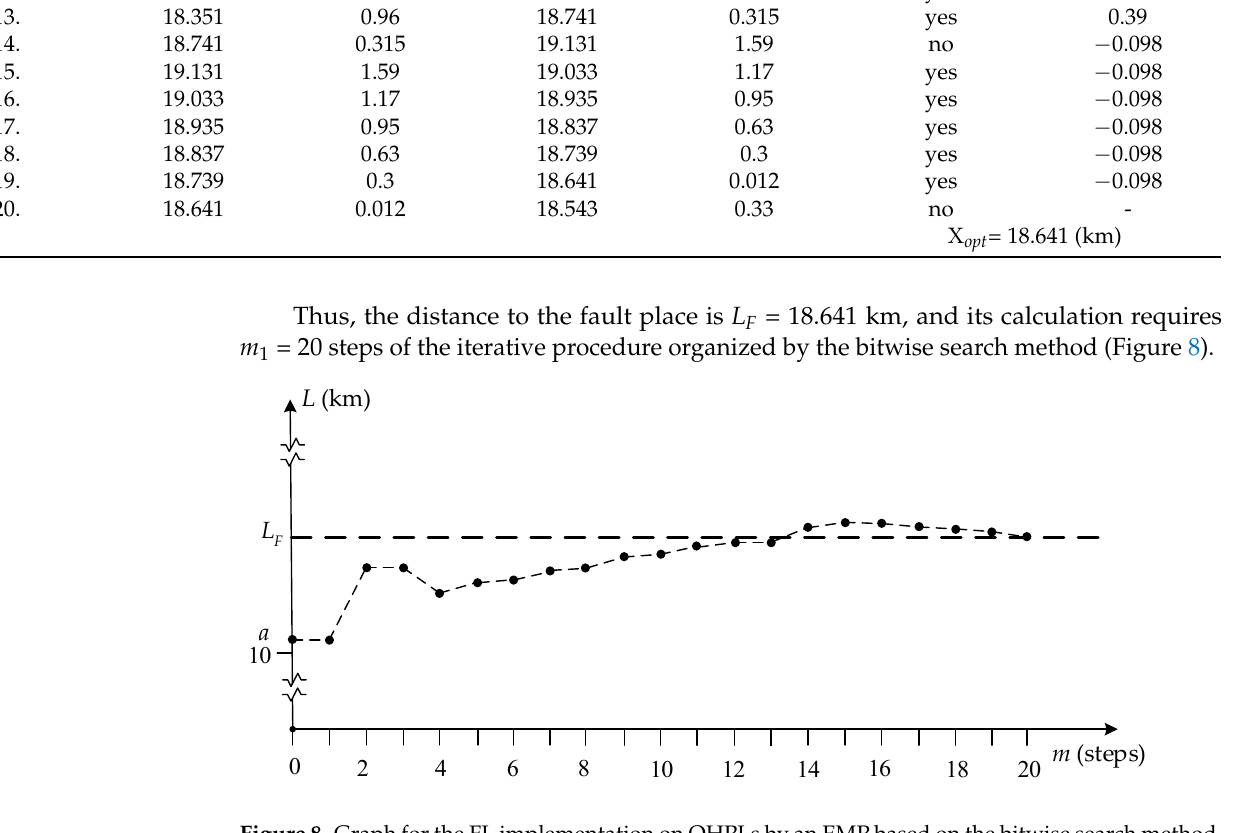
Figure 8. Graph for the FL implementation on OHPLs by an EMP based on the bitwise search